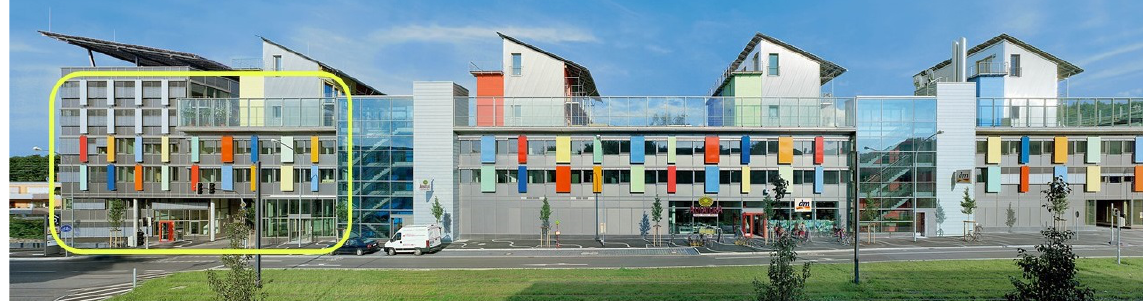
Figure 2. “Western façade of the Sonnenschiff building in Freiburg, Southern Germany. The yellow- coloured marking indicates the part of the building where the room in question was located” [17,26].